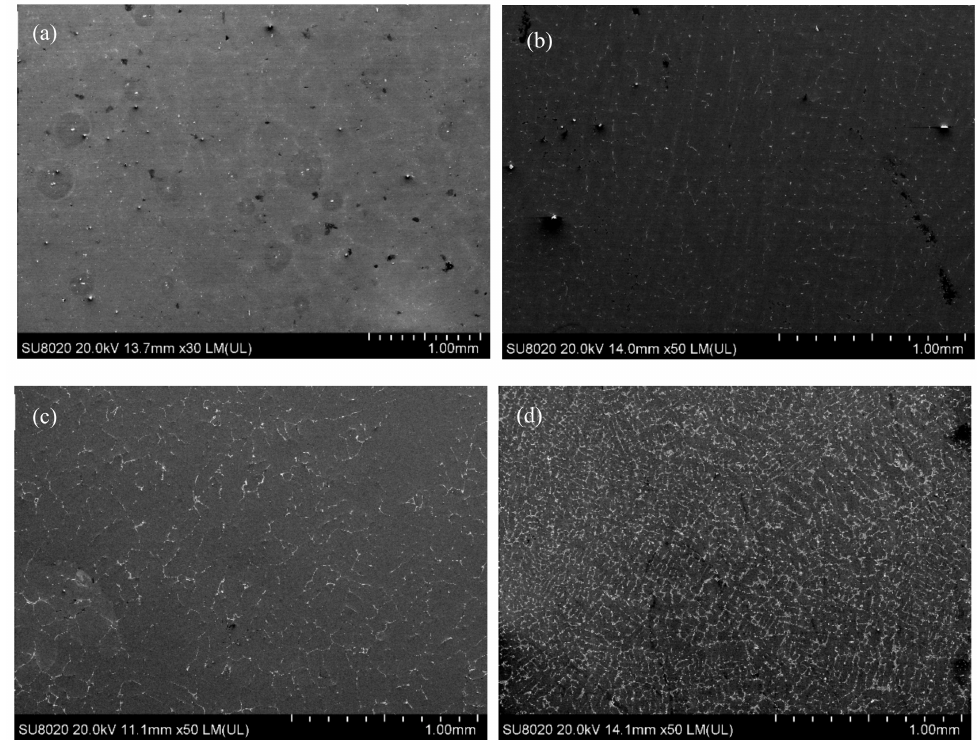
Figure 2. SEM images of Al–5Zn–0.03In– x Er alloys: ( a ) Al–5Zn–0.03In; ( b ) Al–5Zn–0.03In–0.5Er; ( c ) Al–5Zn–0.03In–1Er; ( d )